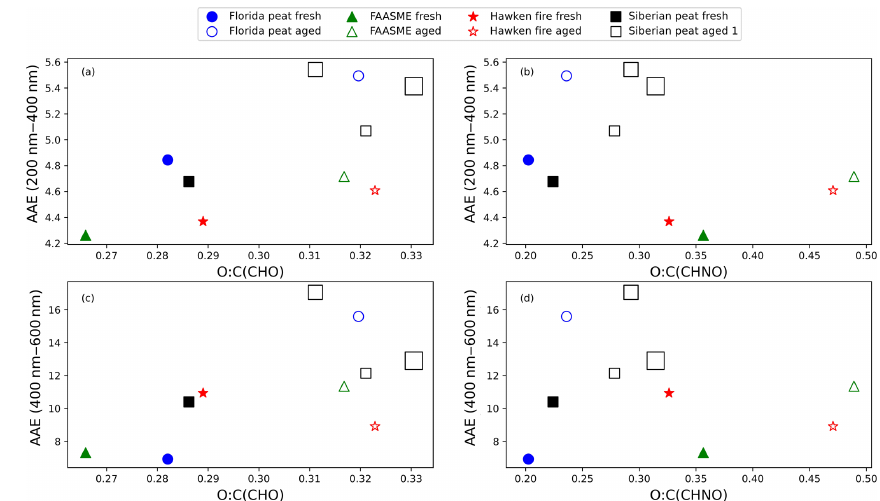
Figure 9. Absorption Ångström exponent (AAE) for the water extracts as a function of oxidation. Solid symbols represent fresh aerosols for a fuel type, and open symbols of the same shape represent the aged aerosols for the same fuel. For Siberian peat, the size of the symbol increases with the oxidation voltage in the OFR reactor.